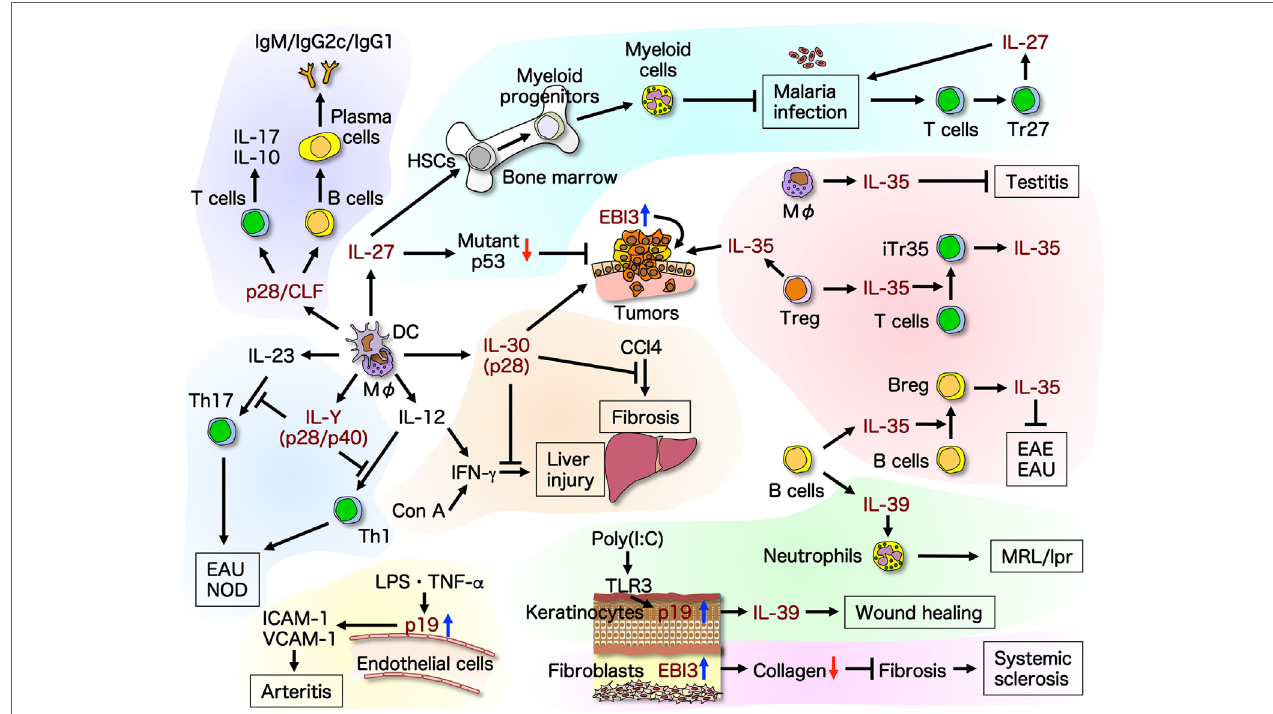
FiguRe 2 | Recent advances in molecular structures and functions of the iL-6/iL-12 family cytokines . Promiscuity within the IL-6/IL-12 family cytokines complicates the structural and functional clarification and assignment of individual cytokines. The roles of this family of cytokines are expanding, and individual cytokine subunits have been shown to have self-standing activities. This illustrates the recent advances in molecular structures and functions of the IL-6/IL-12 family cytokines. Up-arrow in blue and down-arrow in red mean upregulation and downregulation of expression, respectively. Breg, regulatory B; CCl4, carbon tetrachloride; CLF, cytokine-like factor 1; Con A, concanavalin A; DC, dendritic cell; EAE, experimental autoimmune encephalomyelitis; EAU, experimental autoimmune uveitis; HSC, hematopoietic stem cell; ICAM-1, intracellular adhesion molecule-1; LPS, lipopolysaccharide; M Φ , macrophage; NOD, non-obese diabetic; TLR, toll-like receptor; TNF, tumor necrosis factor; VCAM-1, vascular cell adhesion